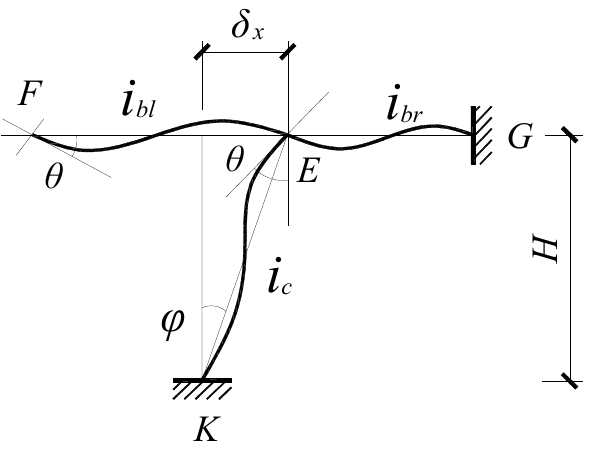
Figure 2. Bar element EK.